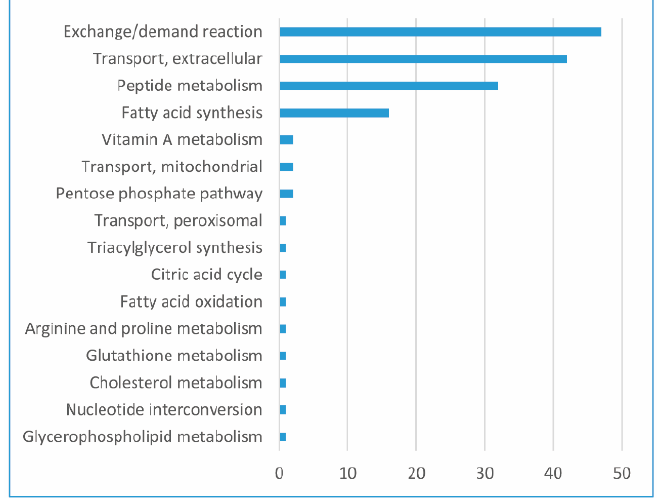
Figure 7. The frequencies of subsystems of important features ( x -axis, the number of reactions) which were selected in random forest analysis for all omics integration CGEMs.